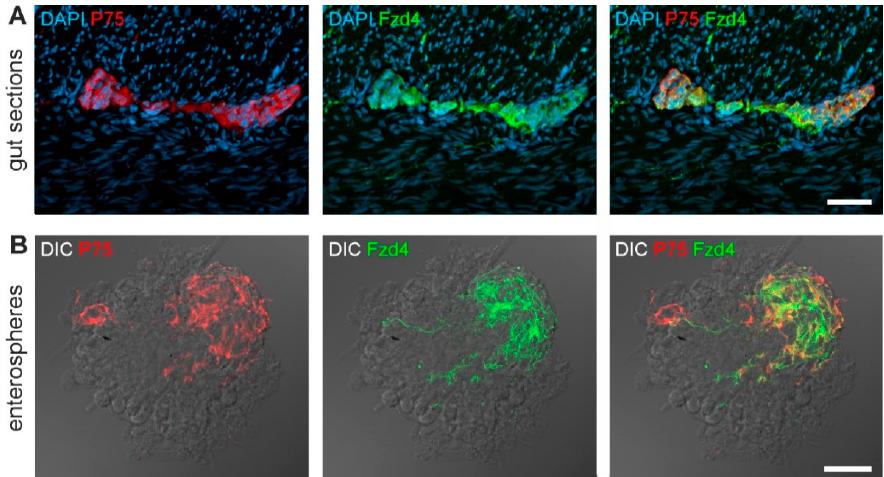
Figure 1. Expression of Fzd4 and P75 NTR in vivo and in Tunica muscularis -derived enterospheres. The micrographs show immunostainings for Fzd4 (green) and P75 NTR (red) in cryosections from Tunica muscularis ( A ) and Tunica muscularis -derived enterospheres ( B ). Fzd4 is expressed in ganglion cell bodies and neurites within the muscle sheets. There is a pronounced co-expression with the putative stem